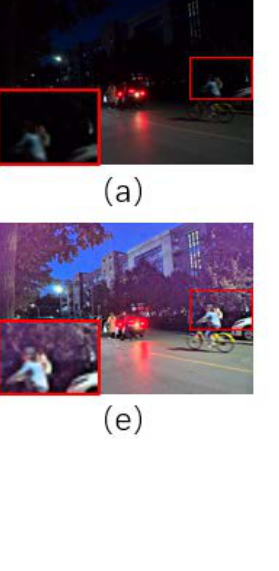
Figure 3. Contrast of indoor image enhancement effect. ( a ) Original image; ( b ) HE; ( c ) Retinex; ( d ) MSR; ( e ) MSRCP; ( f ) LIME; ( g ) RetinexNet; ( h ) Ours.